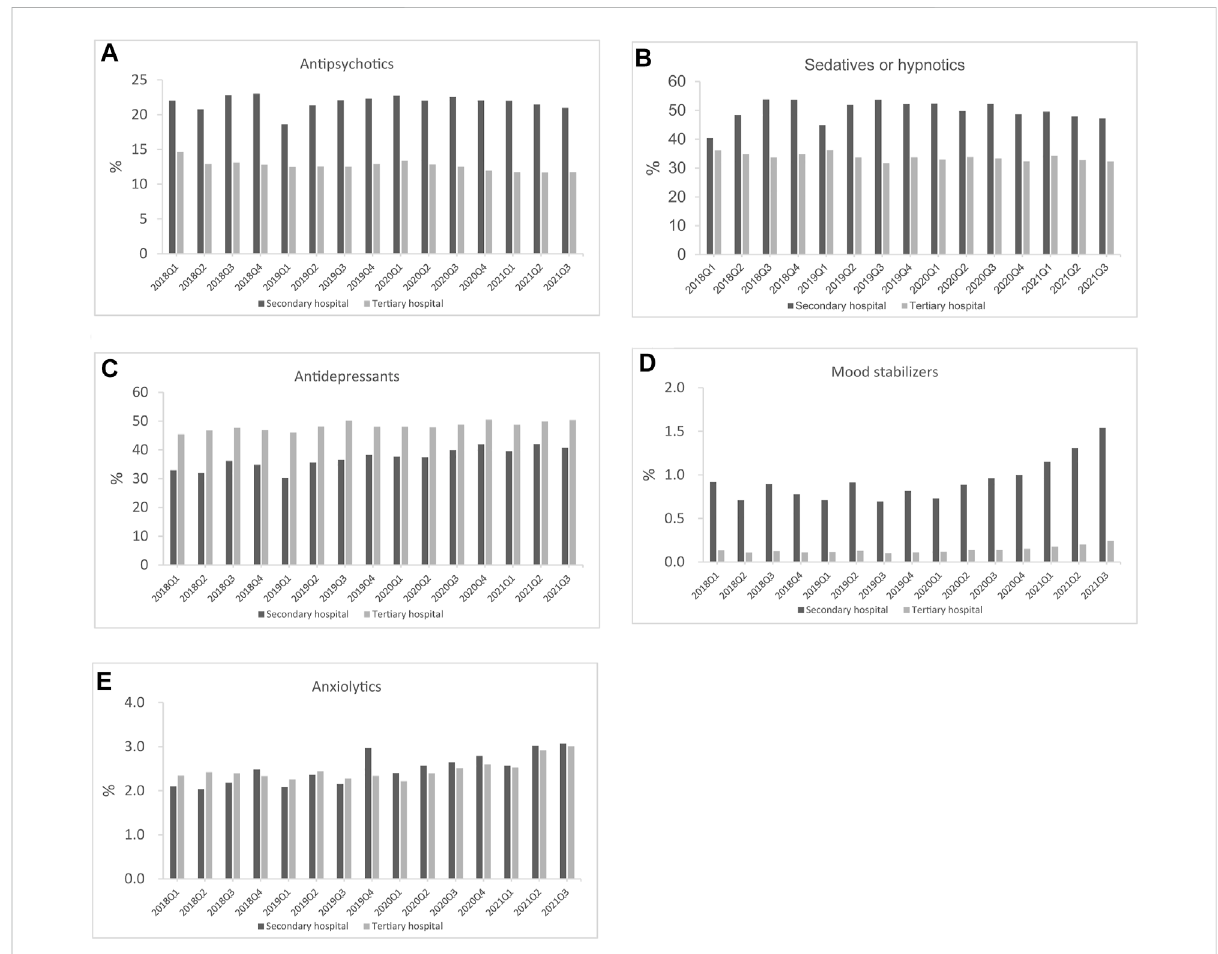
FIGURE 4 Psychotropic utilization for each class in secondary and tertiary hospitals (A) Antipsychotics (B) Sedatives or hypnotics (C) Antidepressants (D) Mood stabilizers (E) Anxiolytics.